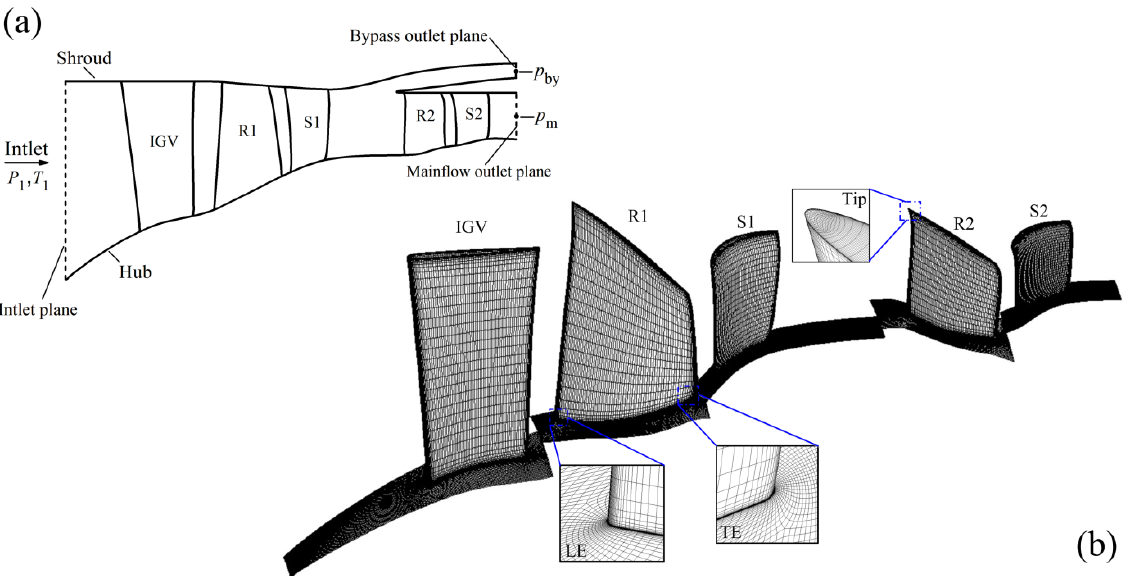
Figure 2. Illustration for boundary conditions in numerical calculation ( a ); computational grid of baseline two-stage transonic compressor at single flow-path mode (SFM) used in numerical simulation ( b ).